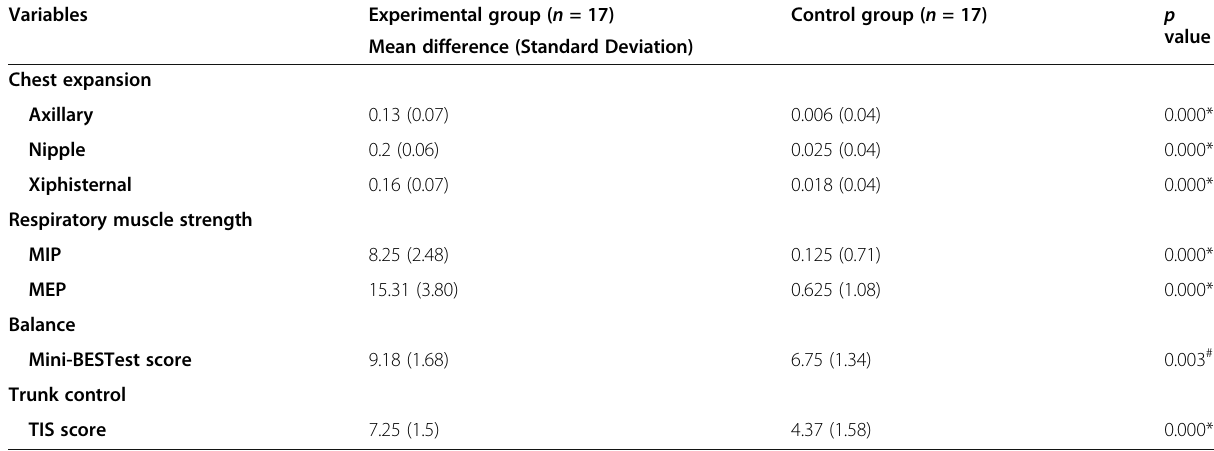
Table 3 Inter-group comparison of chest expansion, respiratory muscle strength, mini-BESTest score, and TIS in the experimental and control